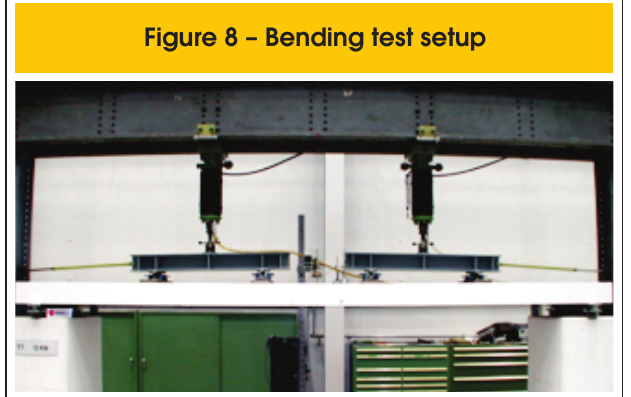
Figure 9 – Beam VFC_NP_01: (a) During test; (b) After premature failure of